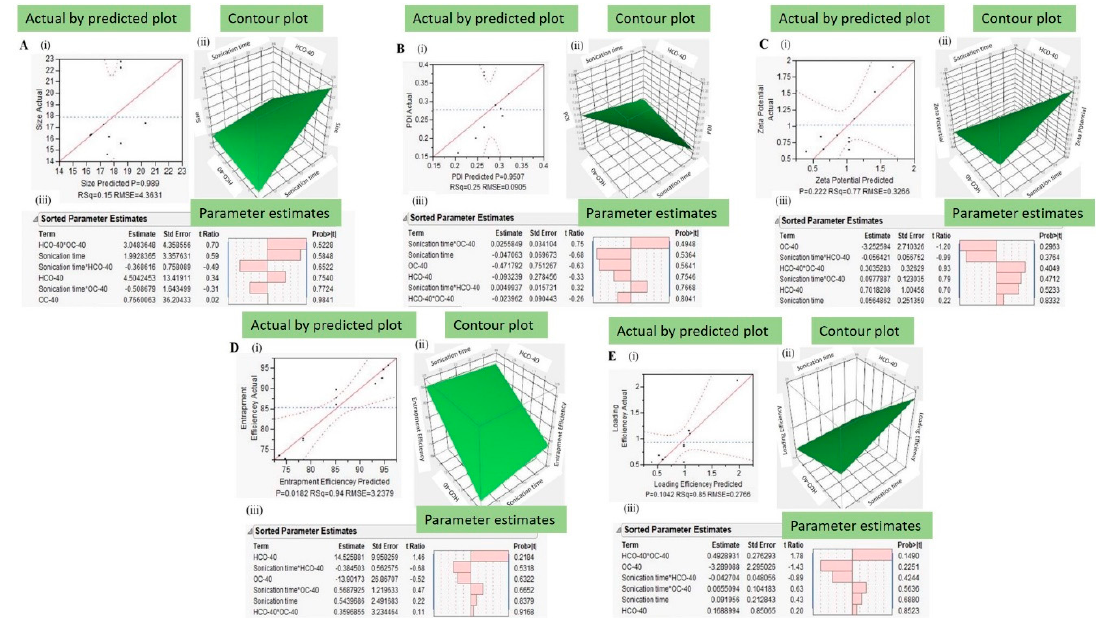
Figure 3. Actual by Predicted plots (i) Contour plots (ii) and Parameter estimates (iii) for dependent variables like Size ( A ), PDI ( B ), Zeta Potential ( C ), Loading Efficiency ( D ) and Entrapment Efficiency ( E ). variables like Size ( A ), PDI ( B ), Zeta Potential ( C ), Loading E ffi ciency ( D ) and Entrapment E ffi ciency ( E ). Contour plots for size, PDI, zeta potential, loading and entrapment e ffi